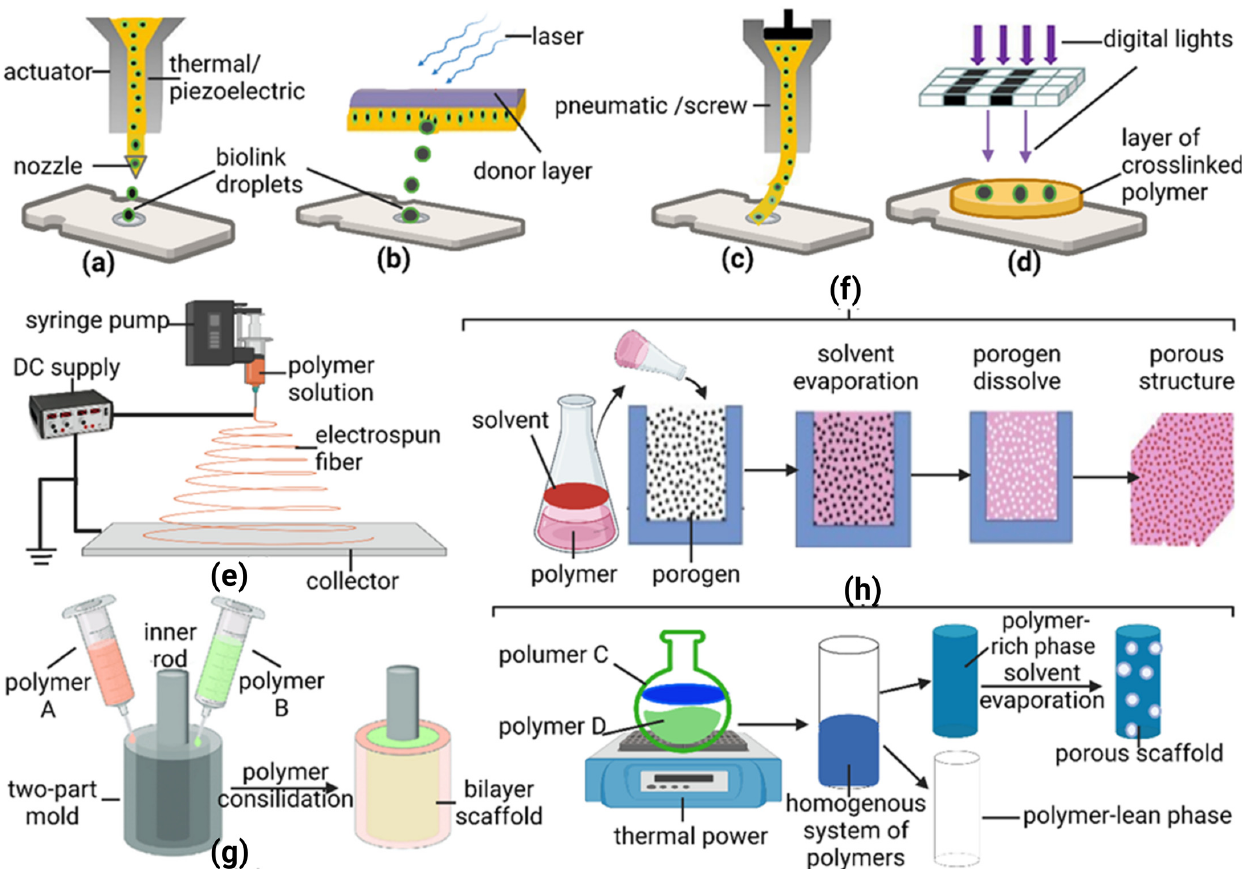
Figure 1. The general process of technologies applied on TEVGs. ( a ) 3D printing-injection, ( b ) 3D printing-laser assisted, ( c ) 3D printing-extrusion, ( d ) 3D printing-stereolithography, ( e ) electrospin- ning, ( f ) casting, ( g ) molding, and ( h ) thermal-induced phase separation (TIPS) of phase inversion.